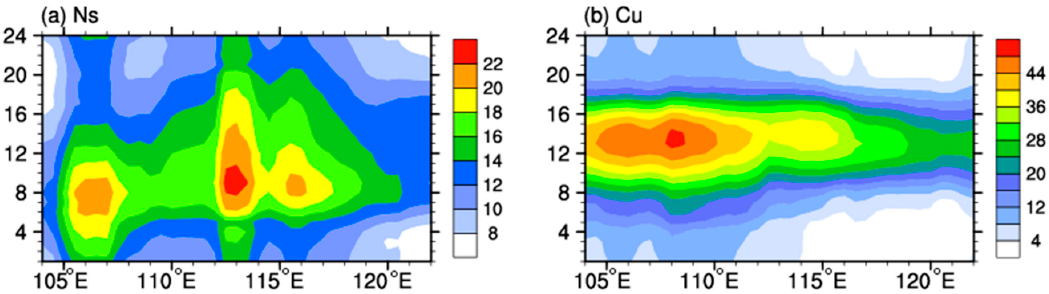
Figure 4. Diurnal variation cycles of clouds with the longitude: ( a ) Ns (averaged over 26–30° N) and ( b ) Cu (averaged over 22–26° N) (the horizontal axis represents the longitude, and the vertical axis is the local solar time in hours).